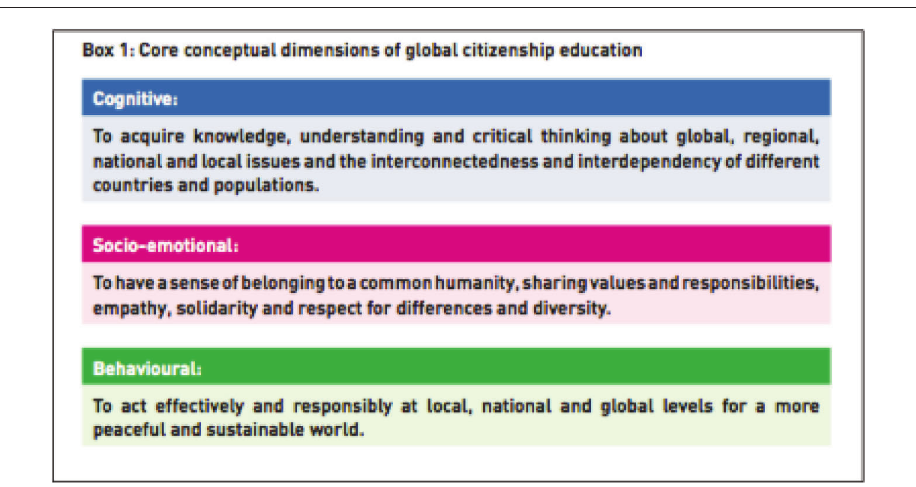
Figure 1: Framing devices contribute to relationships of equivalence and difference Source: UNESCO (2015: